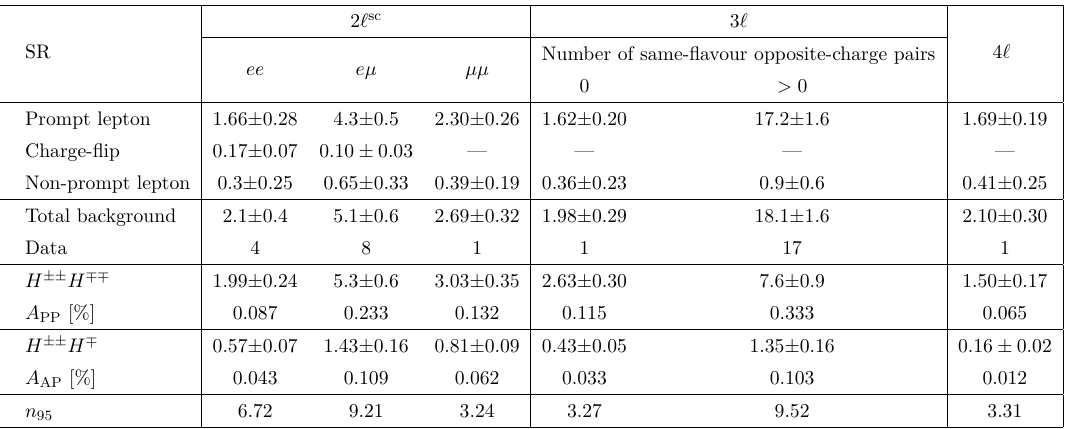
Table 7 . The expected background and the observed data event yields in the signal region defined for the m = 300 GeV mass hypothesis. The signal yield is for the corresponding mass point and H ±± is normalised to the luminosity of 139 fb − 1 . The displayed numbers include all sources of statistical and systematic uncertainties. The overall signal acceptances A limit on extra contributions to each signal region at 95% confidence level, n Selections with µµ , three or four leptons are not affected by the electron charge-flip background, so these contributions are denoted by